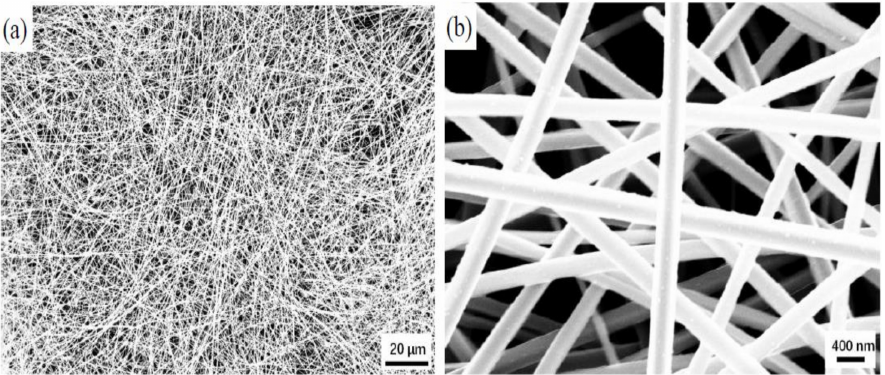
Figure 3. SEM images of ( a ) Ag NWs/C under lower magnification, ( b ) Ag NWs/C under higher